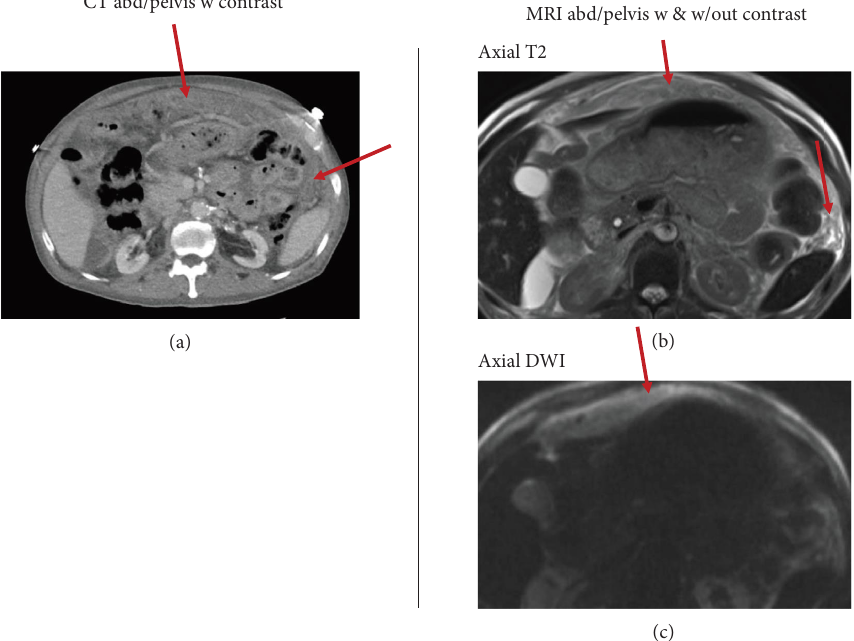
Figure 1: Abdominal imaging upon admission. (a) CTabdomen/pelvis with contrast reveals nodularity in the omentum tracking into the left paracolic gutter (red arrows). MRI abdomen/pelvis with and without contrast shows hyperintense regions on (b) axial T2 weighted sequences and (c) axial difuse weighted imaging sequences, consistent with areas of infammation and nodularity (red arrows) with impression including possibility of peritoneal carcinomatosis or infectious